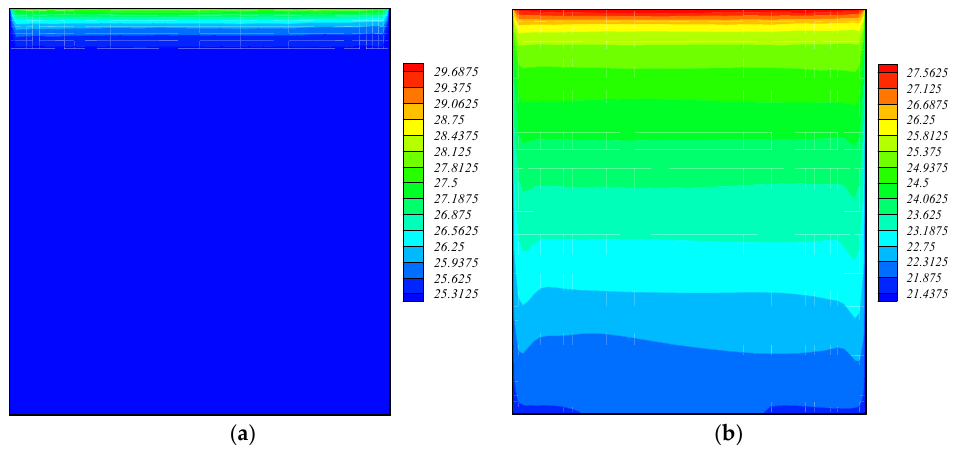
Figure 16. Temperature counters of the roof at 8 h for the room: ( a ) without and ( b ) with PCM. Energies 2016 , 9 , 30